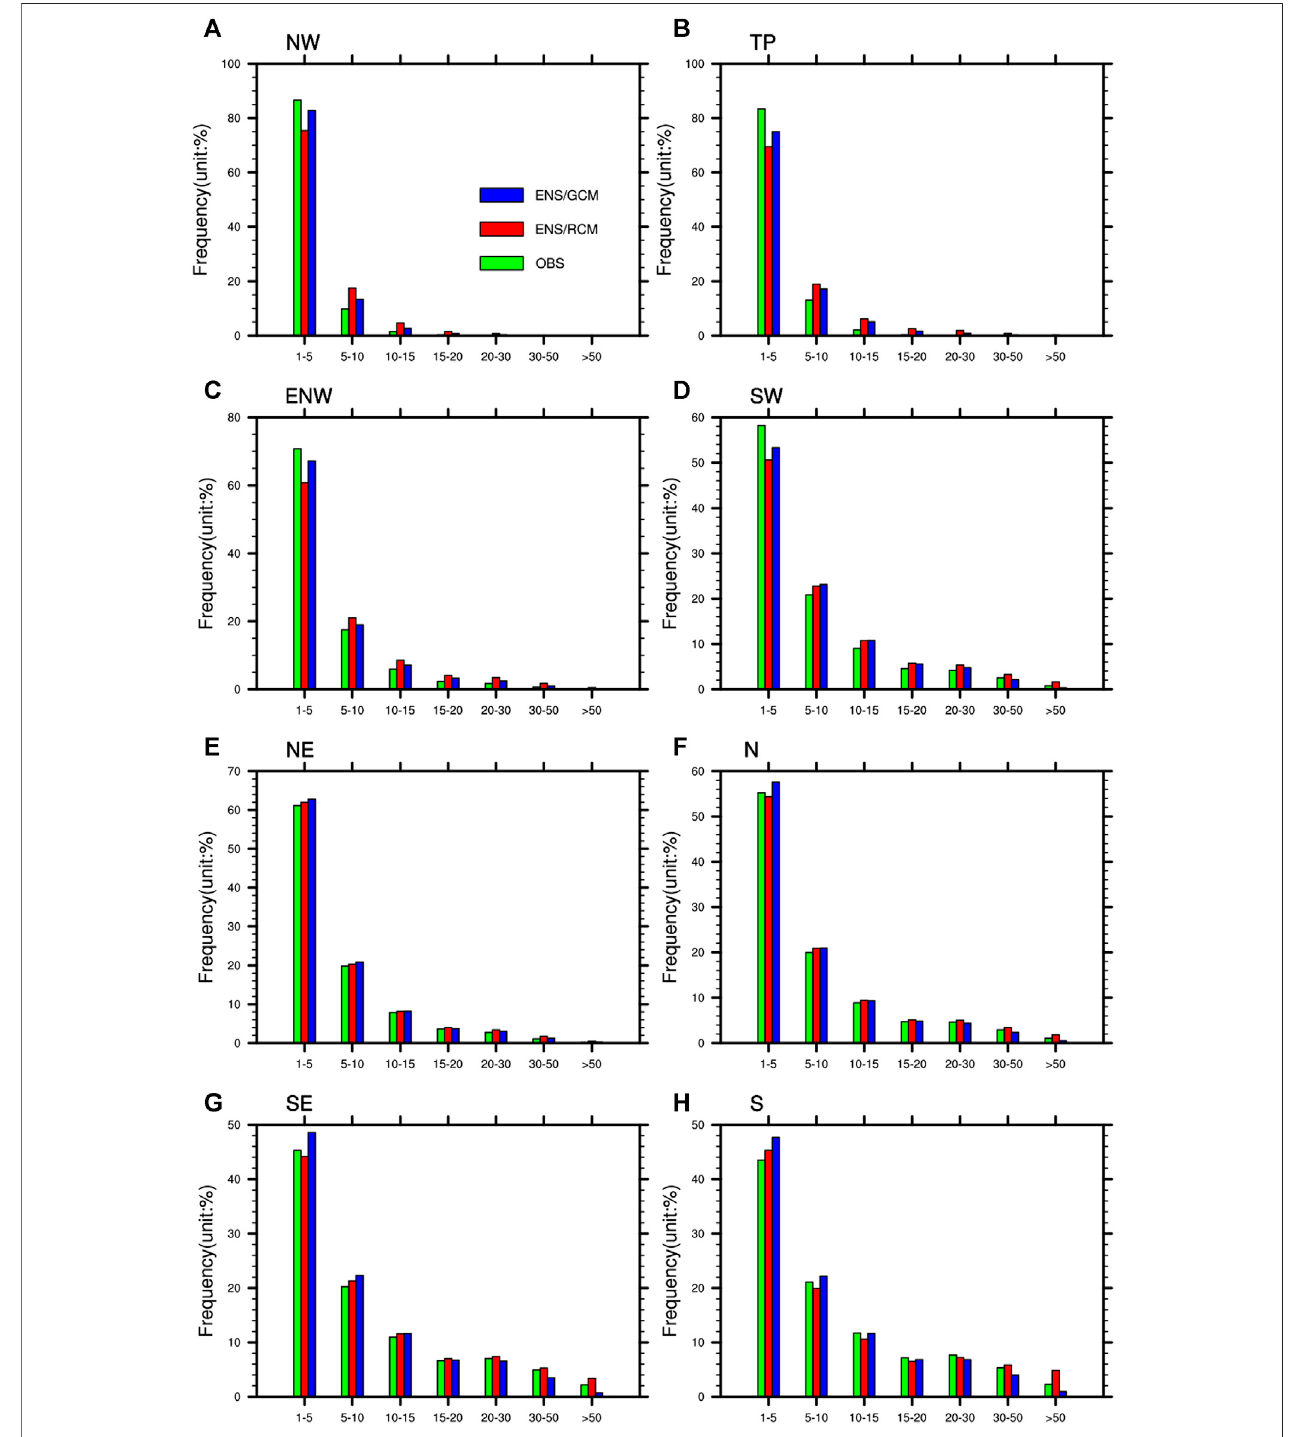
FIGURE 4 | The frequencies of daily precipitation from the simulations and the observation in the eight sub-regions over China. The blue bar and the red bar represent the ensemble mean of GCMs and the RCMs simulations, respectively.